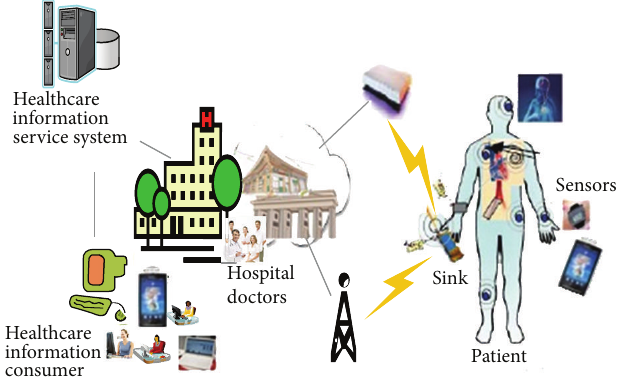
Figure 3: Components of u-healthcare service.